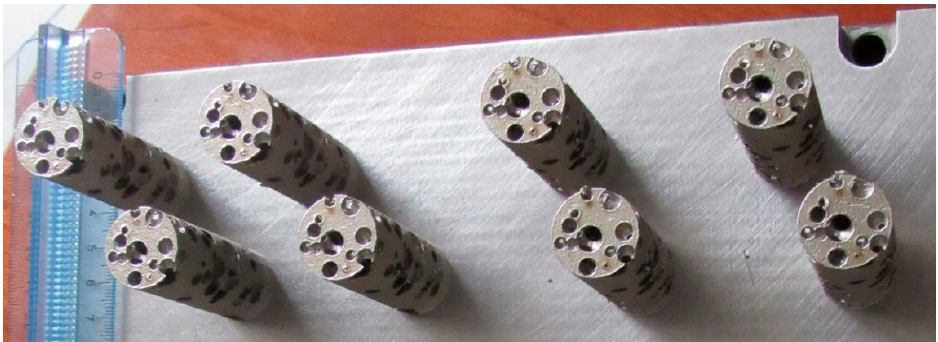
Figure 12. Cylindrical random foams manufactured by means of LPBF.